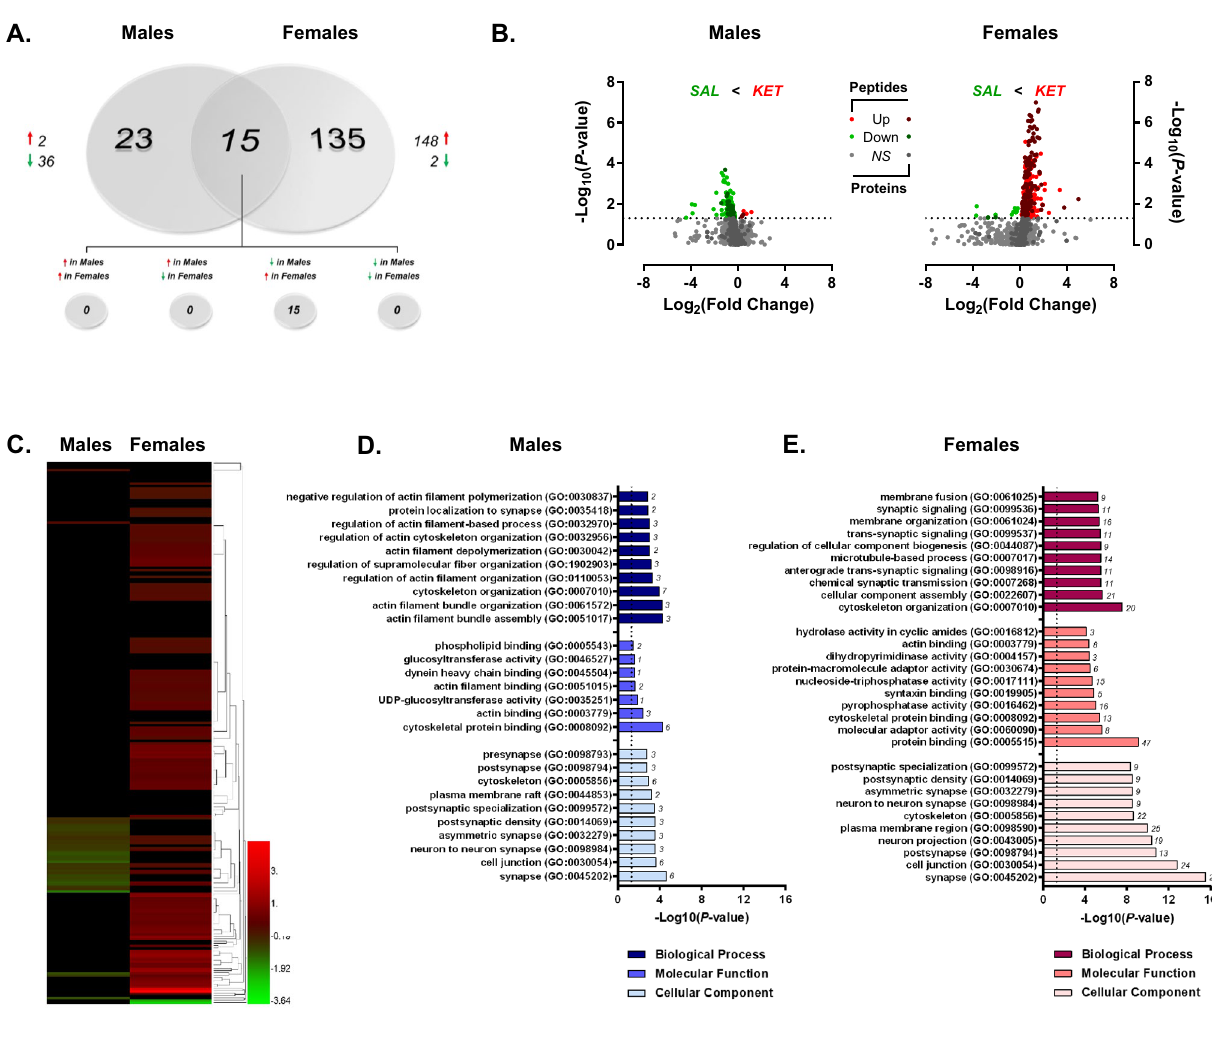
Figure 8. Rapid sex-specific changes in the dHPC phosphoproteome following low-dose ketamine. ( A ) Venn diagram depicting the number of phosphoproteins with significant differential abundance between ketamine (KET)- and saline (SAL)-treated male and female rats. Red arrows indicate greater levels observed in KET- vs. SAL-treated rats. ( B ) Volcano plots showing significant KET-induced alterations in phosphoprotein abundance in male (left) and female (right) rats. Log 2 (Fold Change) values > 0 (red) indicate higher—and those < 0 (green) lower—abundance in KET-treated rats compared to SAL groups. Points above the horizontal dashed line represent proteins with p < 0.05 (FDR threshold set at 1%). ( C ) Heat map illustrating fold change of phosphoproteins whose abundance was significantly affected by KET in male and female rats. Top 10 most significant ( p < 0.05) gene ontology (GO) enrichment terms per category of phosphoproteins with significant KET-induced differential abundance in the male ( D ) and female ( E ) rat dHPC. Heat map ( C ) was produced in GENE-E (Broad Institute; https:// softw are. broad insti tute. org/